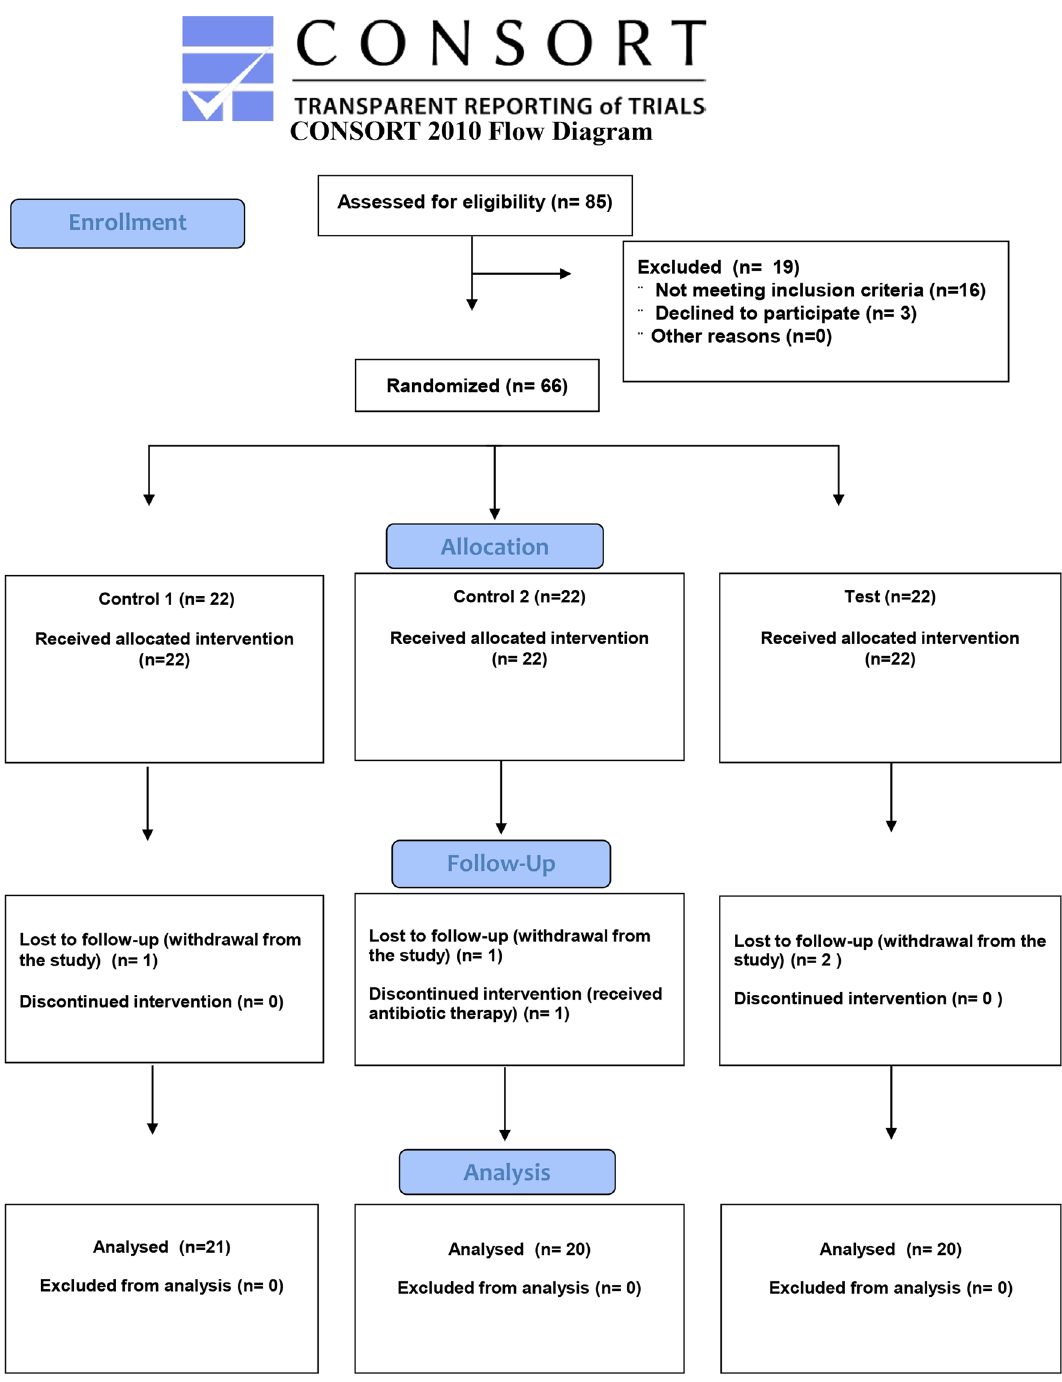
Figure 1. CONSORT flow diagram showing the enrolment, allocation, follow-up, and analysis of the participants in the